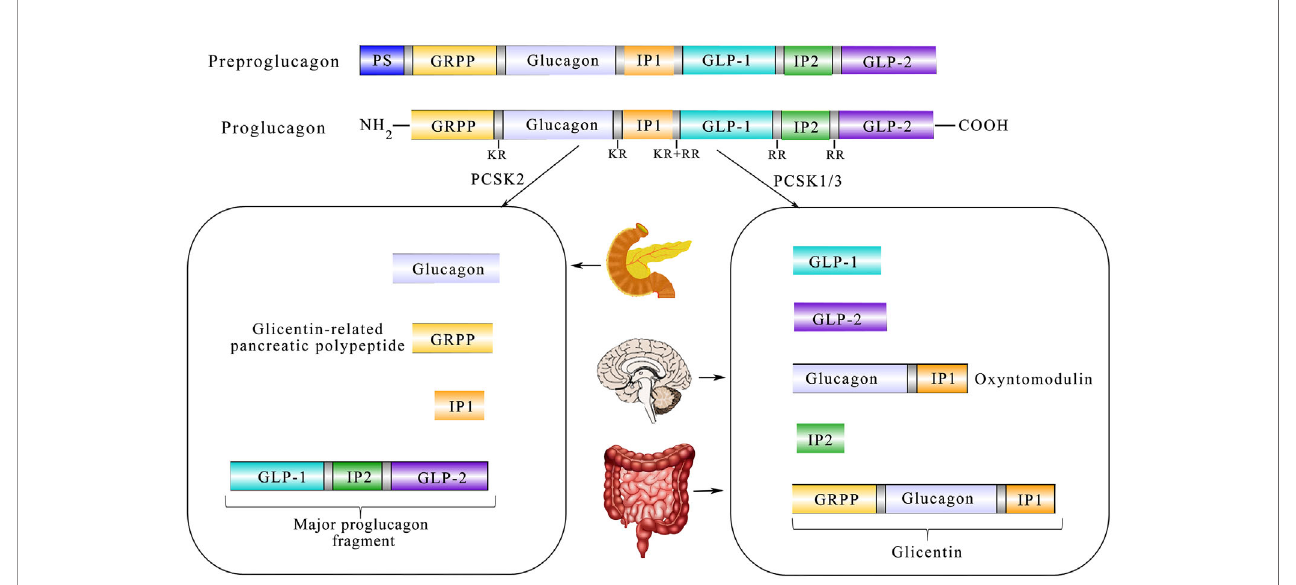
FIGURE 1 | Diagram showing the relationship between translation and post-processing of glucagon precursors and its physiological processing pattern in the tissue. Coded by the preproglucagon gene, proglucagon is catalyzed by PCSK1/3 in the gut and brain and further processed to glicentin-related pancreatic polypeptide (GRPP) and oxyntomodulin (OXM), GLP-1, intervening peptide-2 (IP-2), and GLP-2. In the a -cells of the pancreatic islet, PCSK2 predominates and processes proglucagon to glucagon, GRPP, intervening peptide 1 (lP1), and a proglucagon